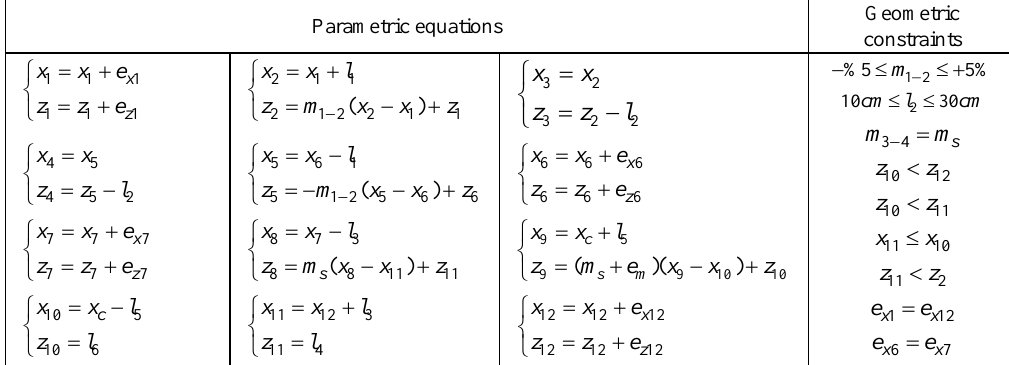
Table 1. The parametric equations and geometric constraints of the cross-section model. The parameter m s is equal to the slope of the cross section of the body element. The parameter m 1-2 is equal to the slope of the sidewalk. The parameter e is the error tolerance in a small interval.